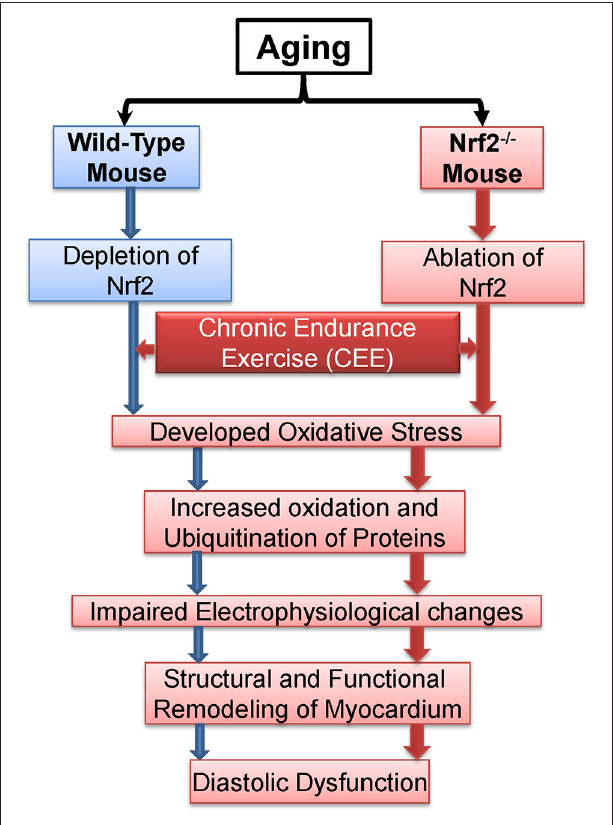
FIGURE 9 | Proposed model demonstrating the effects of chronic endurance exercise (CEE) on cardiac remodeling under Nrf2